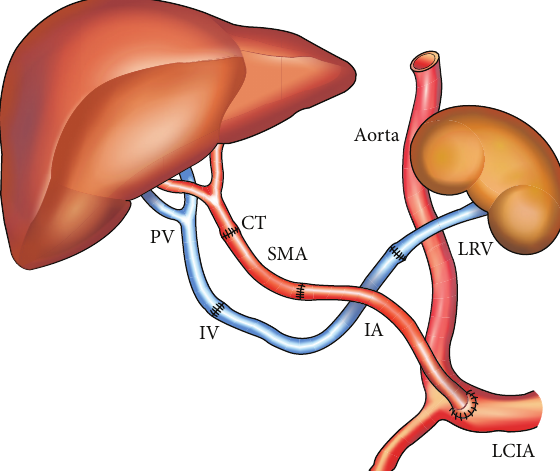
Figure 3: Complex reconstruction of portal and arterial flow to the allograft. Portal flow: end-to-end renoportal anastomosis with iliac vein graft interposition (PV: portal vein; IV: iliac vein graft; LRV: left renal vein); arterial flow: superior mesenteric artery (SMA) and iliac artery (IA) grafts (same donor) interposed between graft celiac trunk (CT) and left common iliac artery